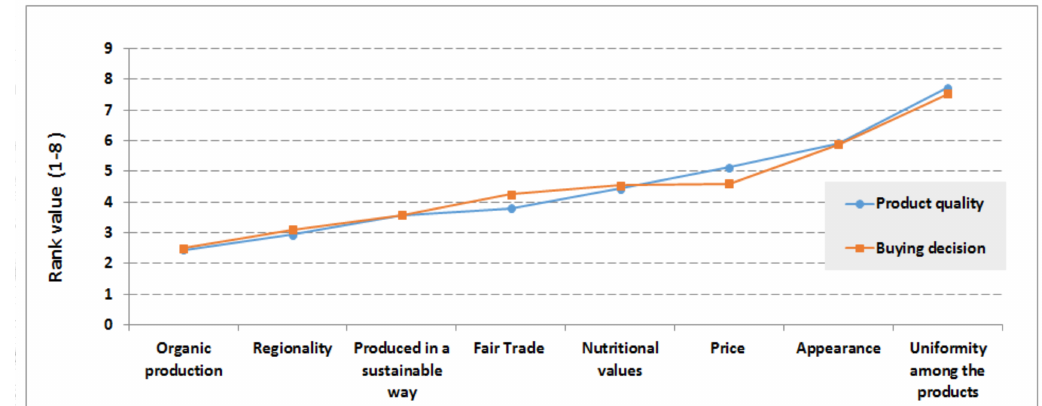
Figure 6. Relationship between perceived product quality and buying decision by participants who believed organic farming is more sustainable. The average ( N = 72) rank values (vertical-axis) were computed for each of the eight parameters (see horizontal axis).